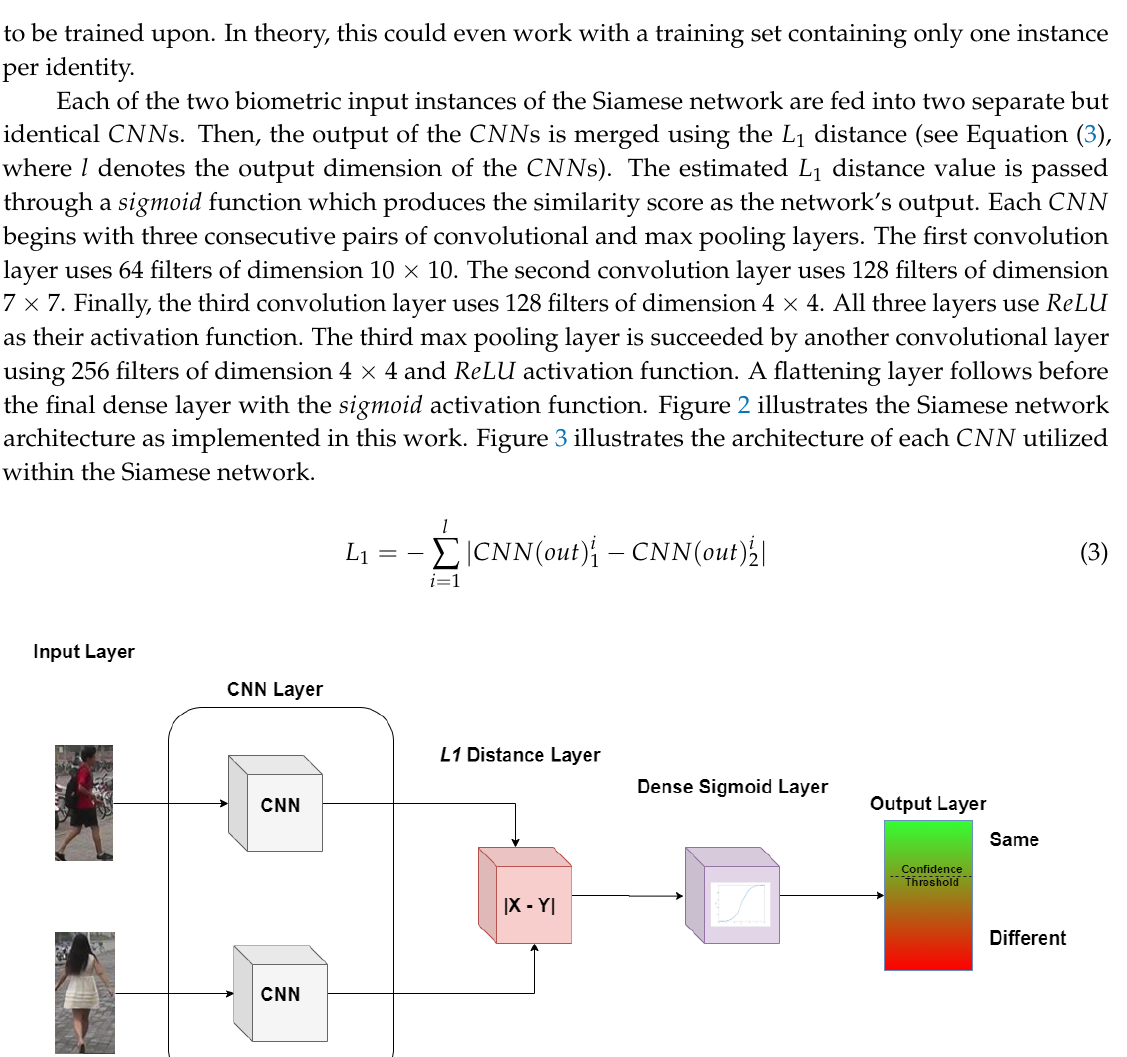
Figure 2. Siamese network architecture as implemented in the current work.